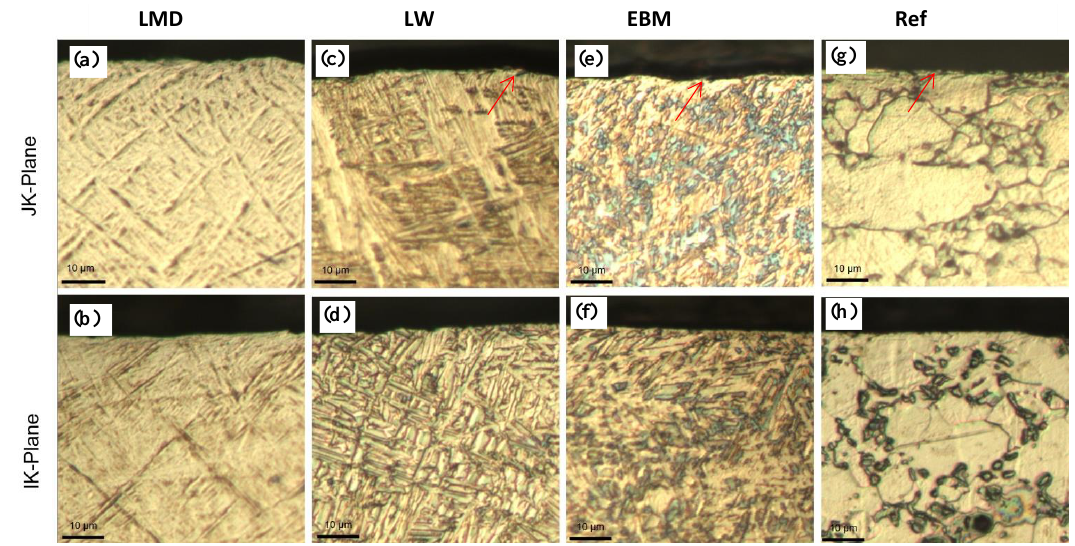
Figure 10. Machined layer and subsurface deformation of the three AM Ti-6Al-4V alloys and the forged reference. Images of LMD, LW, EBM, and reference materials were taken in the JK- ( a , c , e , g ) and IK-planes ( b , d , f , h ). Arrows indicate deformed grains. Note that ( a , c ) are perpendicular to the build direction and ( b , d , e , f ) are within the built plane.